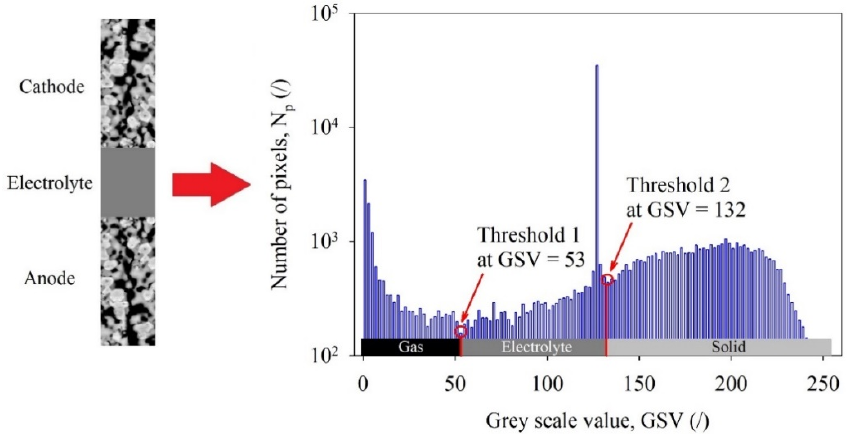
Figure 4. Detection of two threshold values to differentiate three phases from a grey-scale image [10].